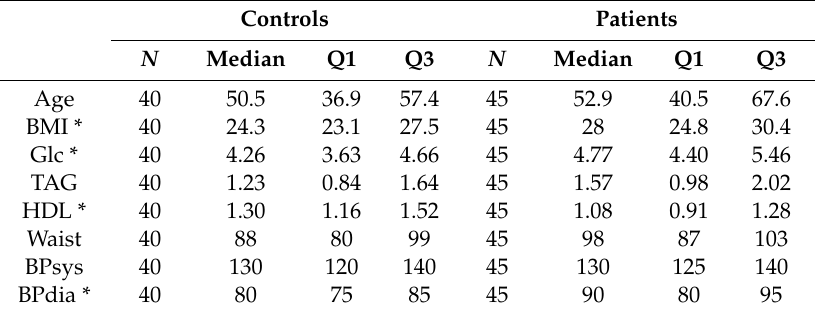
Table 1. Age, body mass index (BMI) and metabolic syndrome (MetS) in participants.